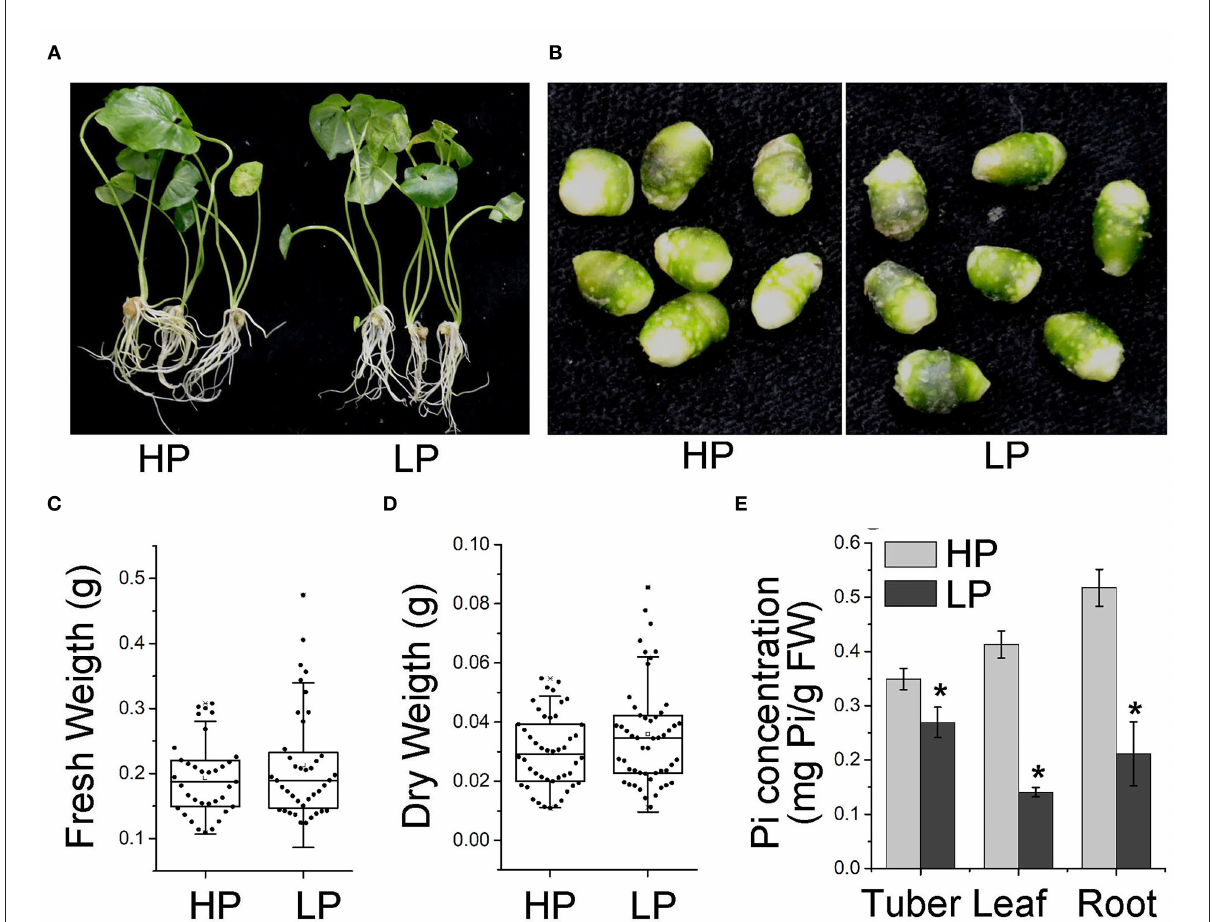
FIGURE1 Phenotype of P. ternata in conditions of high and Low Pi. Phenotype of P. ternata whole plants (A) and tubers (B) cultured in HP and LP medium for 7 days. (C,D) Effect of Pi starvation on the tubers of P. ternata in terms of wet (C) and dry (D) weight. (E) Pi concentration in the tubers, leaves, and roots of P. ternata upon Pi starvation treatment for 7 days. Values are means ± SD of three biological replicates. * P < 0.05, Student’s t -test. HP: high Pi, 10mM. LP: low Pi, 10 µ